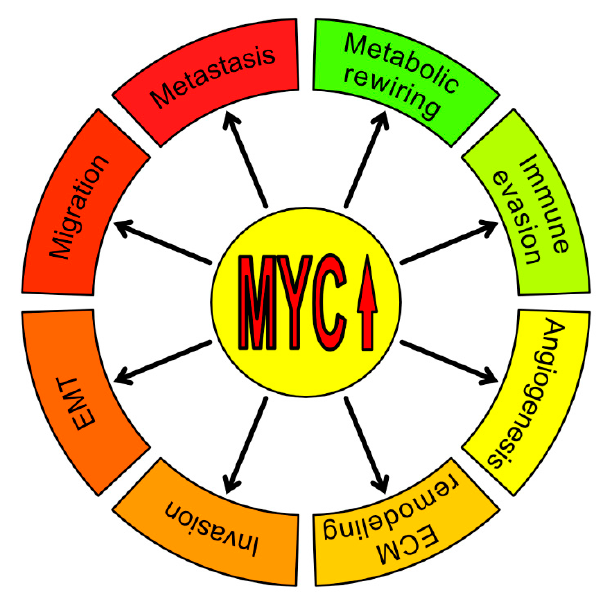
Figure 1. The role of MYC in cancer aggressiveness and progression. An increasing number of studies show that, besides the canonical functions such as cell proliferation, growth, differentiation, self- renewal, survival, metabolism, protein synthesis, and apoptosis, MYC is also directly or indirectly involved in other processes necessary for tumor progression—metabolic rewiring, immune evasion, angiogenesis, ExtraCellular Matrix (ECM) remodeling and invasion, migration, Epithelial-to-Mesenchymal Transition (EMT) and metastasis.